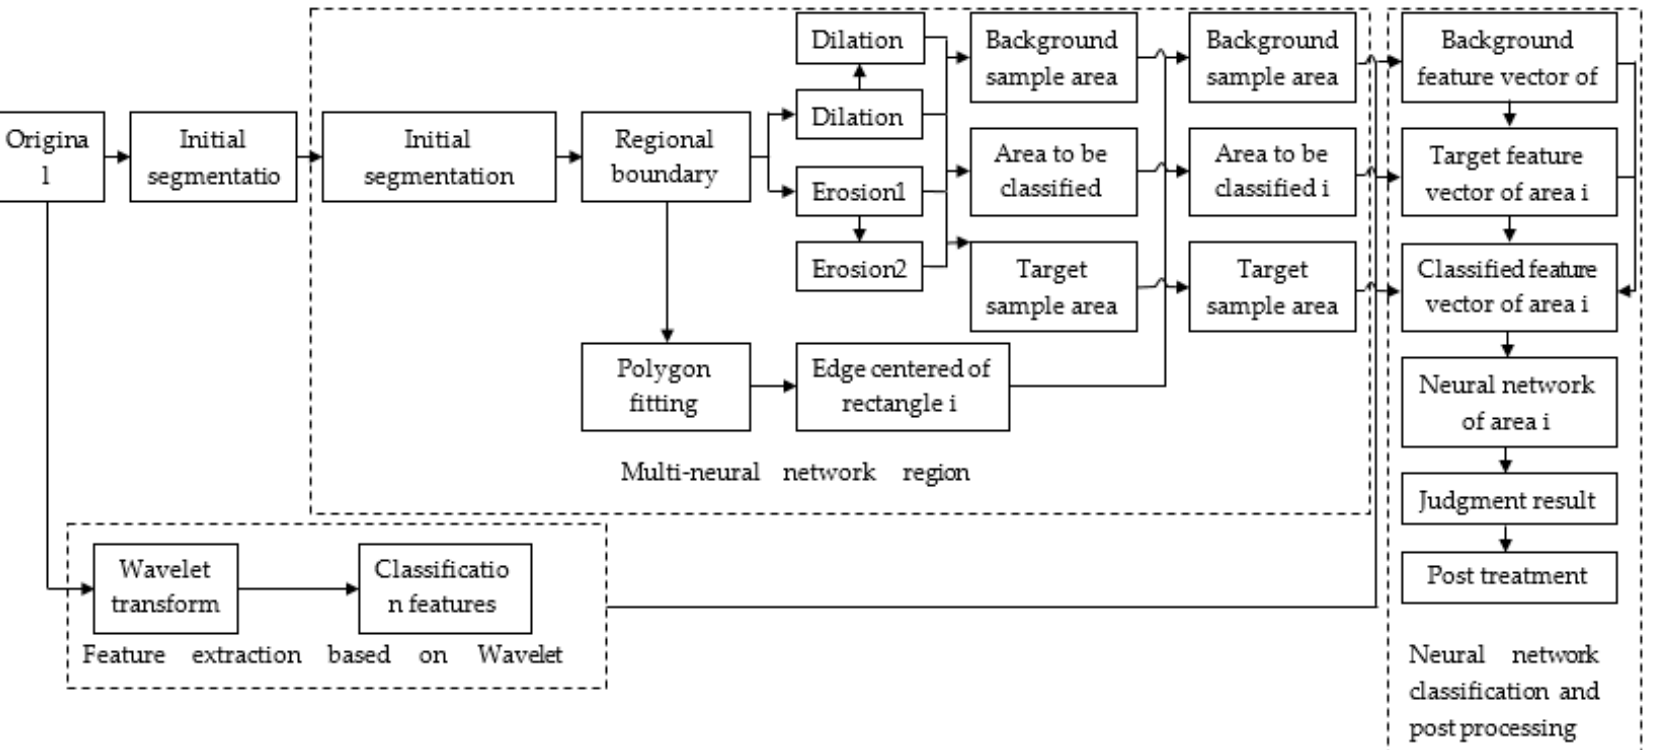
Figure 6. The framework of the multi-neural network segmentation algorithm.